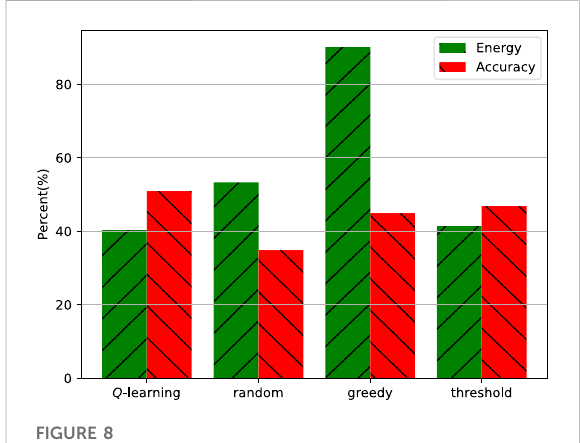
TABLE 3 Simulation parameters of the ideal channel model.